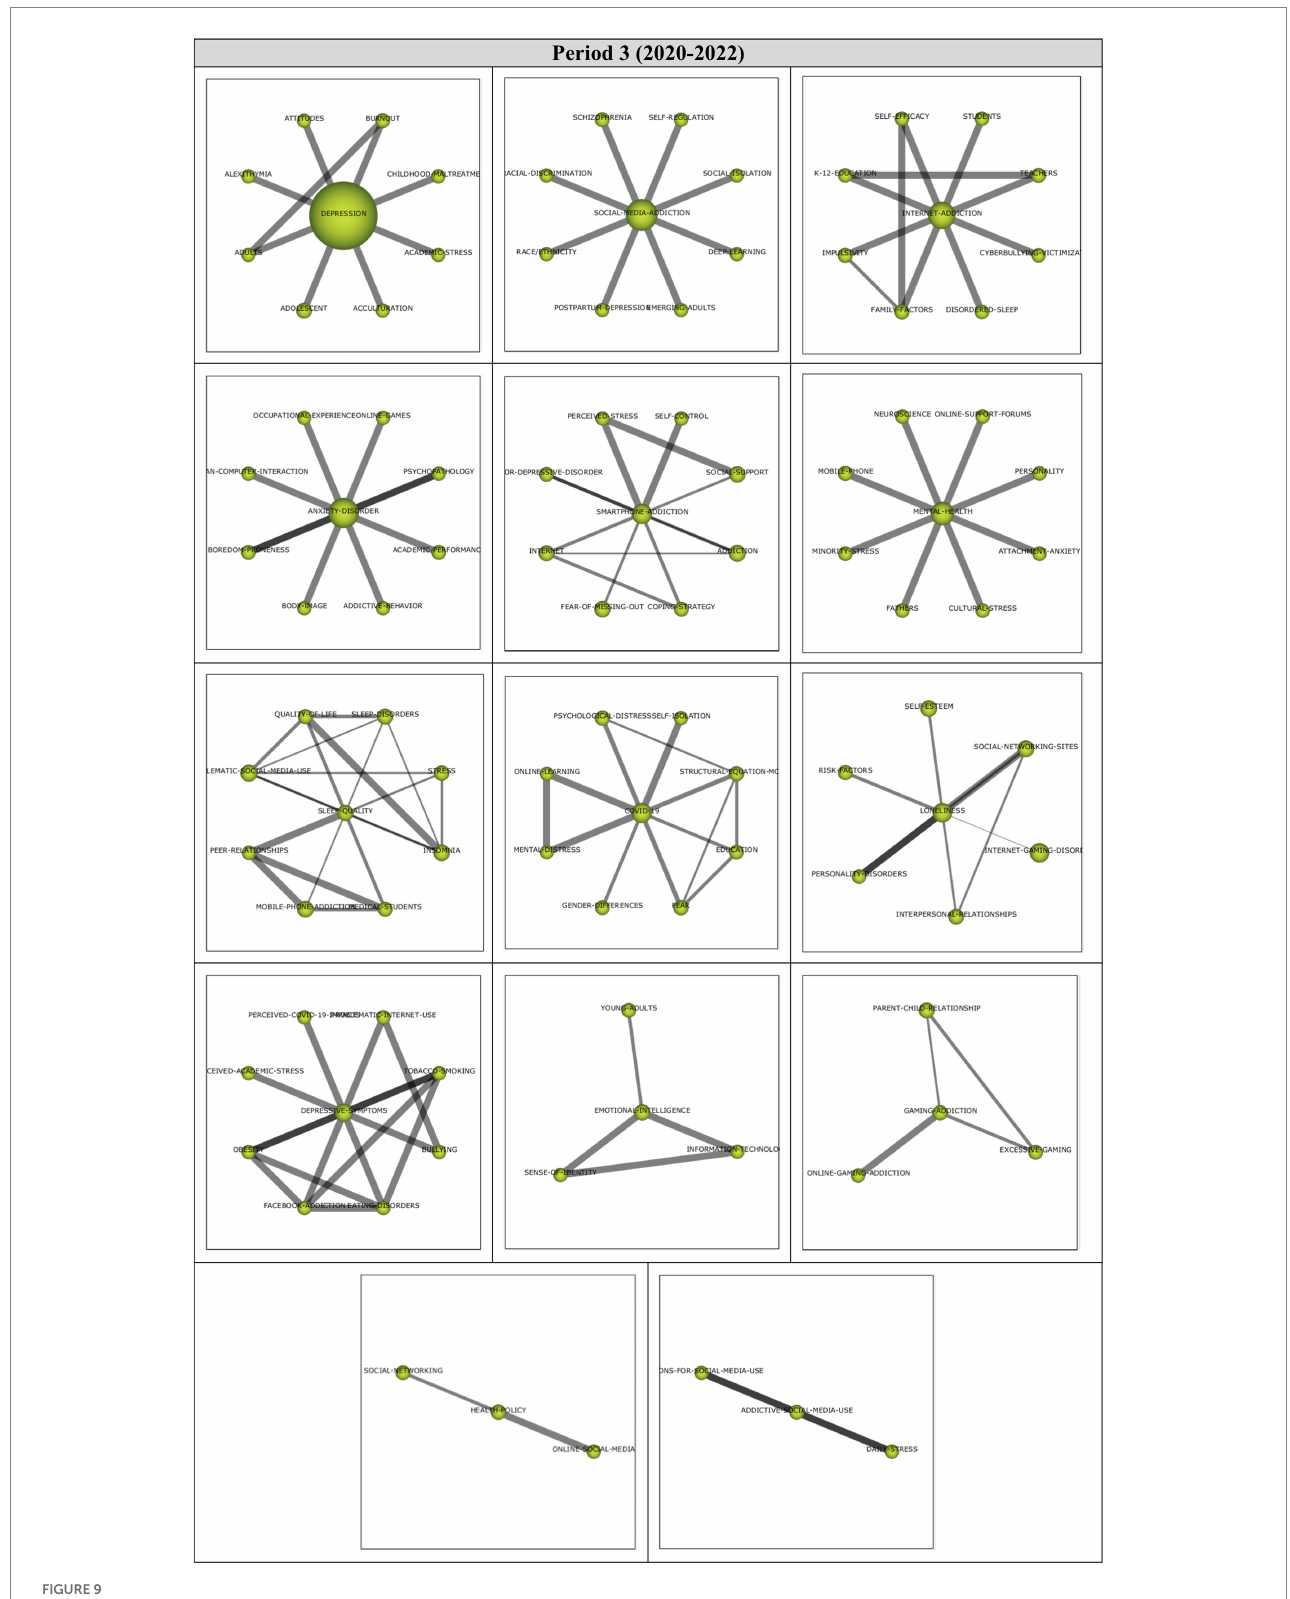
FIGURE 9 Thematic network